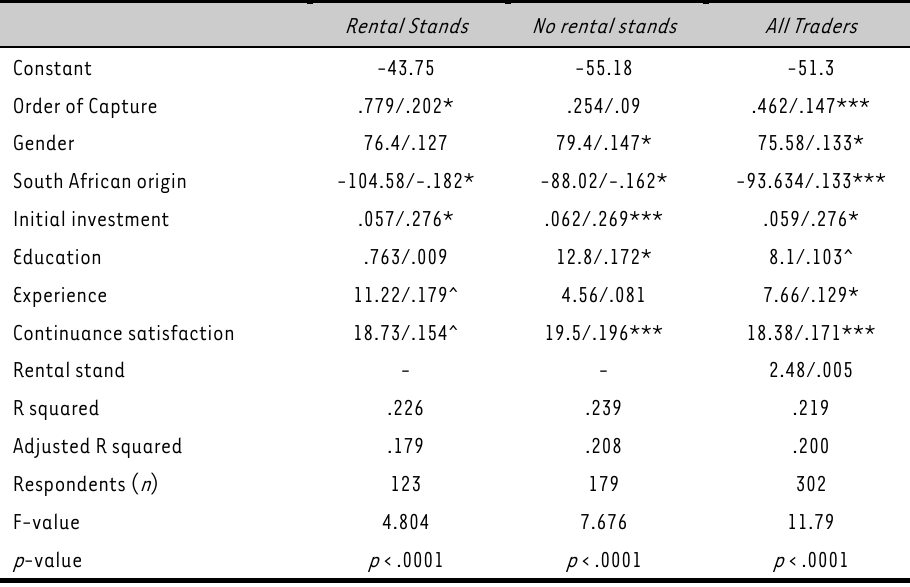
TABLE 2: Multiple Linear Regression Results, 2010 Rental Stands No rental stands All Traders Constant